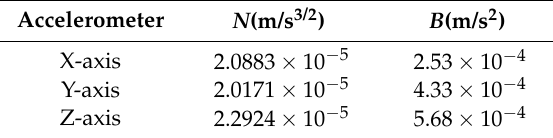
Table 3. Results of Accelerometer Allan Variance.